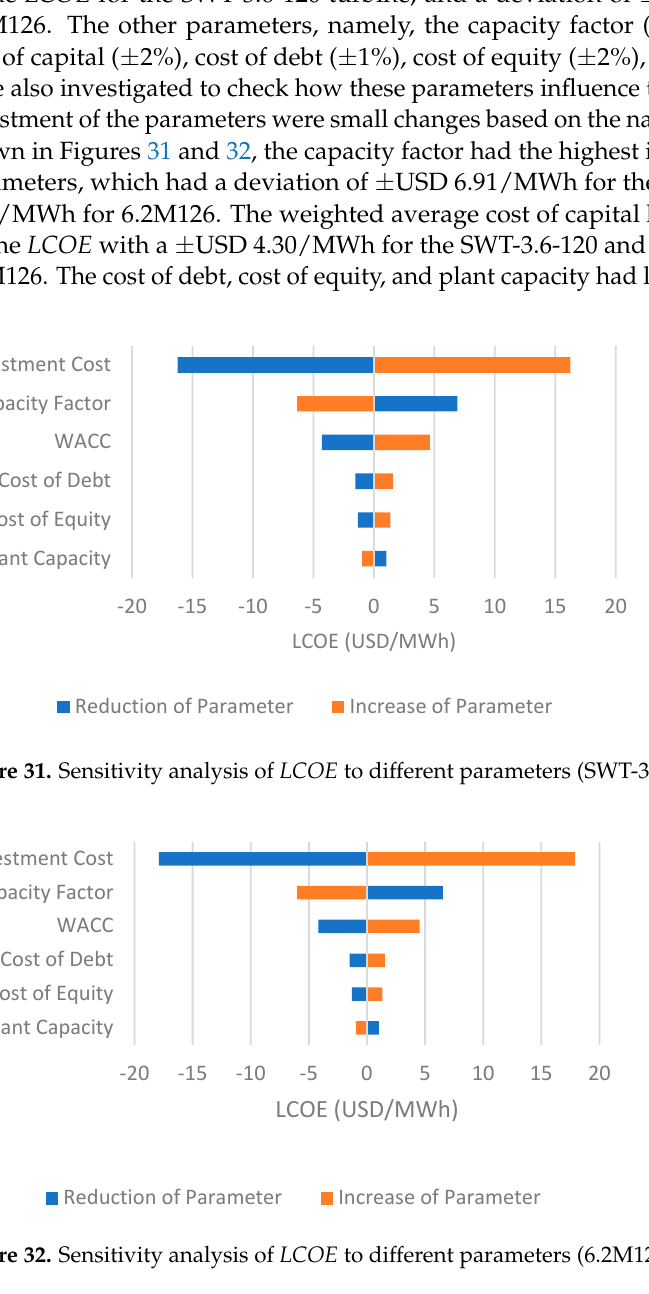
Figure 32. Sensitivity analysis of LCOE to different parameters (6.2M126).